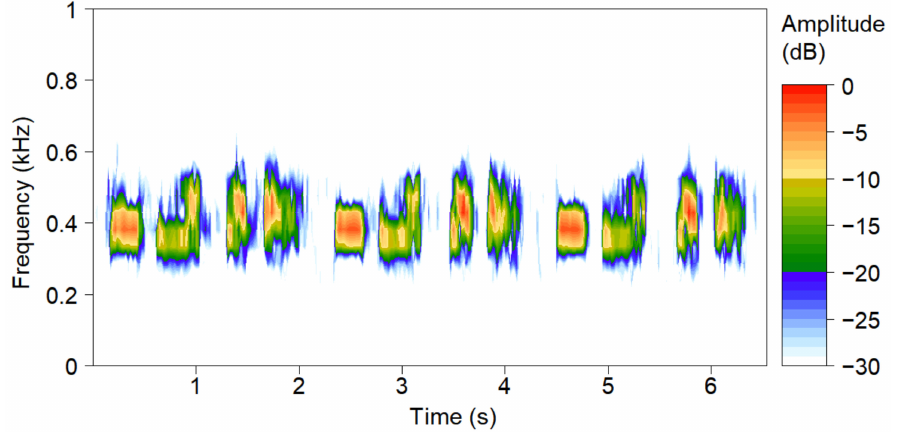
Figure 2. The acoustic spectrum of a typical call of the Oriental Turtle